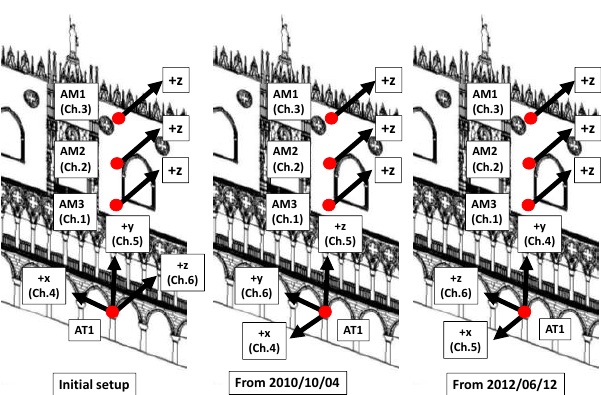
Figure 4. Setup of the accelerometers on Southern façade